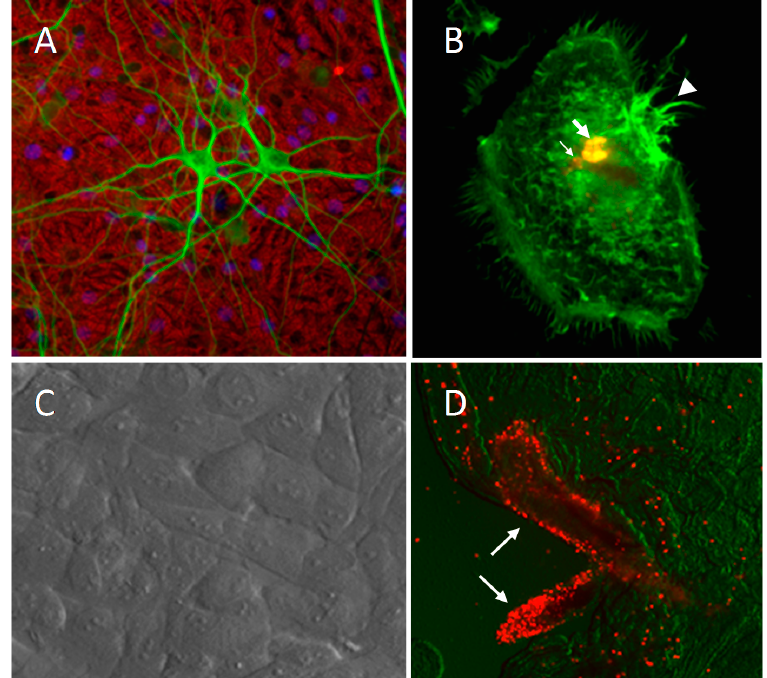
Figure 4. Examples of feline cells grown in culture for basic research on neuro-immune interactions and FIV neuropathogenesis. Excellent recognition of feline proteins is seen with a variety of antibodies to standard markers. ( A ) Neurons identified with MAP-2 immunocytochemistry (green) on a bed of GFAP immunoreactive astrocytes (red). ( B ) A cultured feline choroid plexus macrophage stained with an antibody to FIV (red) and counterstained with phalloidin (green) to show actin structure. FIV is compartmentalized within the cells (large arrow) and can be also seen in small endosome-like structures (small arrow). Ruffles are expressed on the surface of the cell and prominently on one side (arrowhead). ( C ) Cultured feline microvascular endothelial cells viewed with differential interference contrast. ( D ) Macrophages stained with DiI-acetylated-LDL (red) are prominent surrounding penetrating vessels in a whole mount preparation of choroid plexus illustrating the abundance of these cells at the blood-CSF